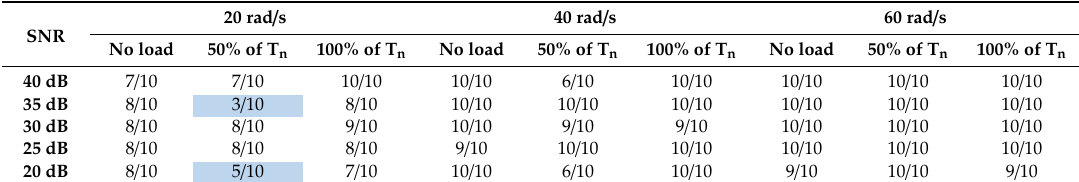
Table 5. KLD performances with P D >